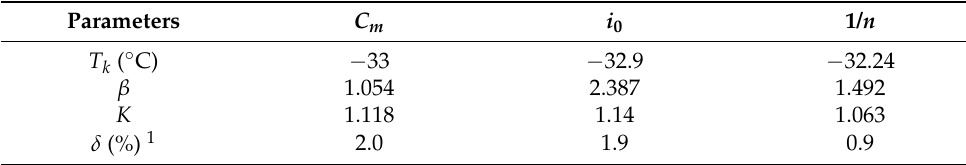
Table 2. Optimal values of the Equation (11) parameters. Parameters C m i 0 1/